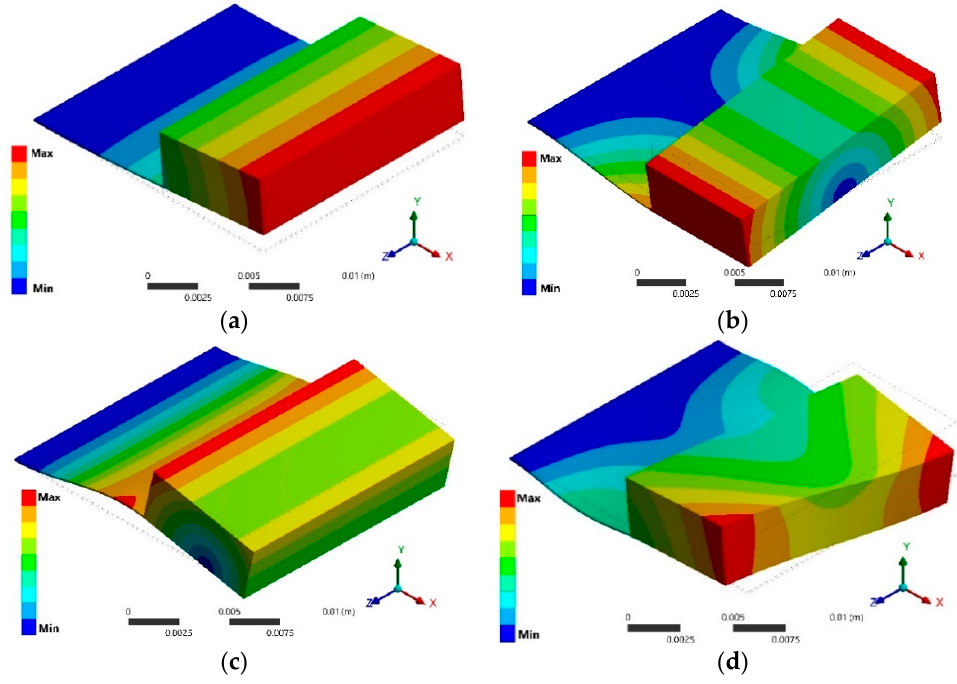
Figure 10. First four vibrations modes of the FEM model of the pVEH microdevice: ( a ) first (38.5 Hz), ( b ) second (142.87 Hz), ( c ) third (371.65 Hz) and ( d ) fourth (2738.7 Hz) vibration mode.